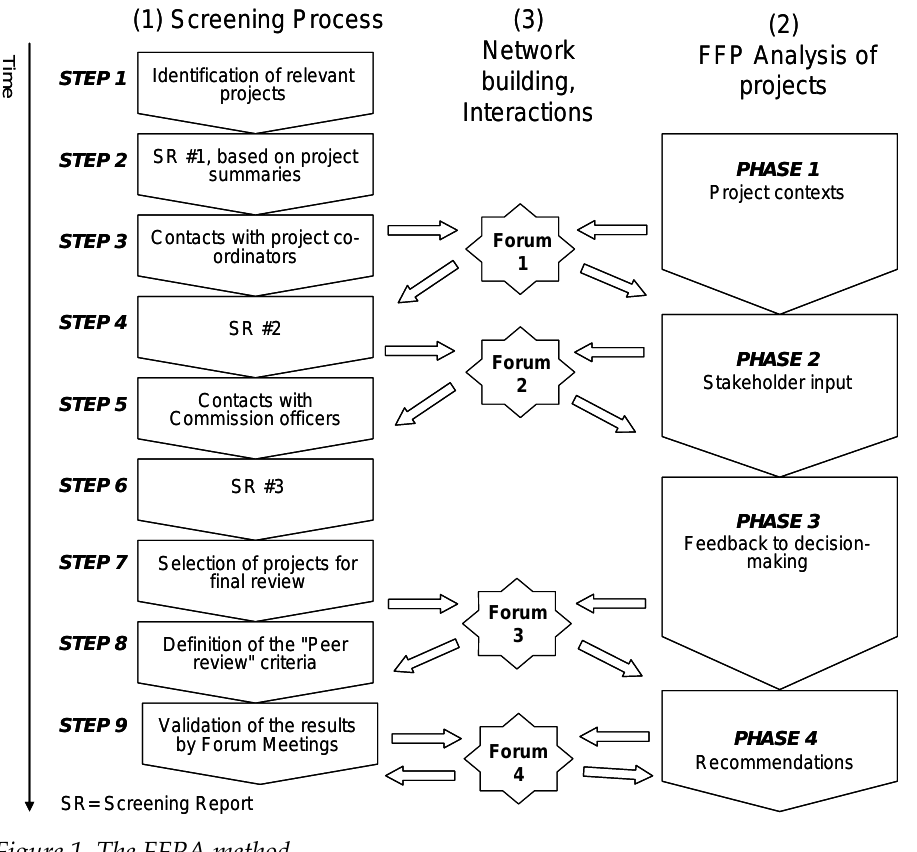
Figure 1. The FFPA